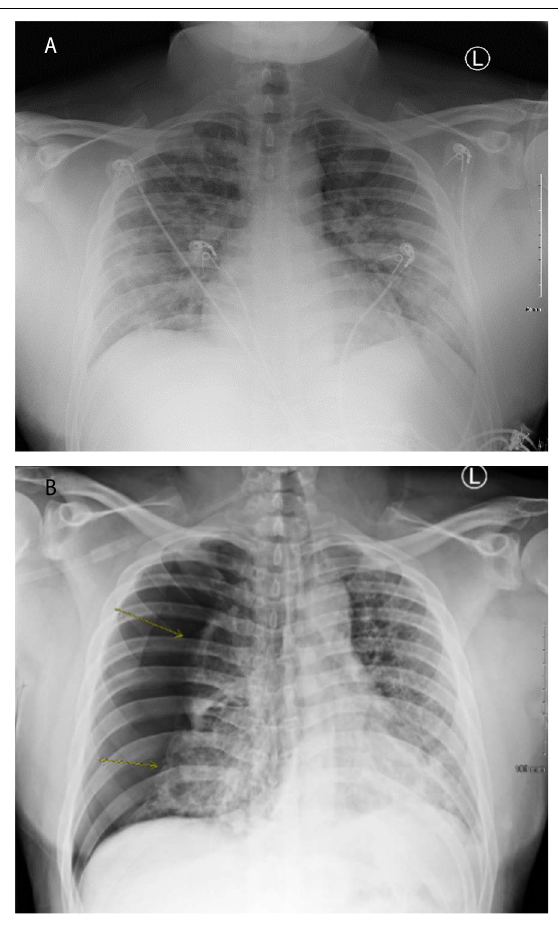
Figure 1. (A): Patient’s chest x-ray taken during the previous hospitalization, showing extensive bilateral interstitial airspace opacities throughout the right and left lungs. (B): Patient's chest x-ray at presentation showing a large right pneumothorax, with the majority of the right lung collapsed. There is mild to moderate mediastinal shift to the left. Both lungs show evidence of bilateral airspace/interstitial disease.